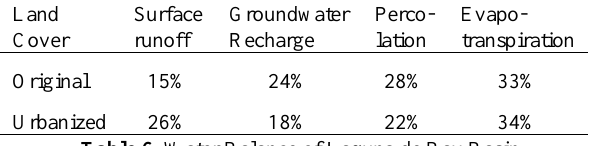
Table 6 . Water Balance of Laguna de Bay Basin.